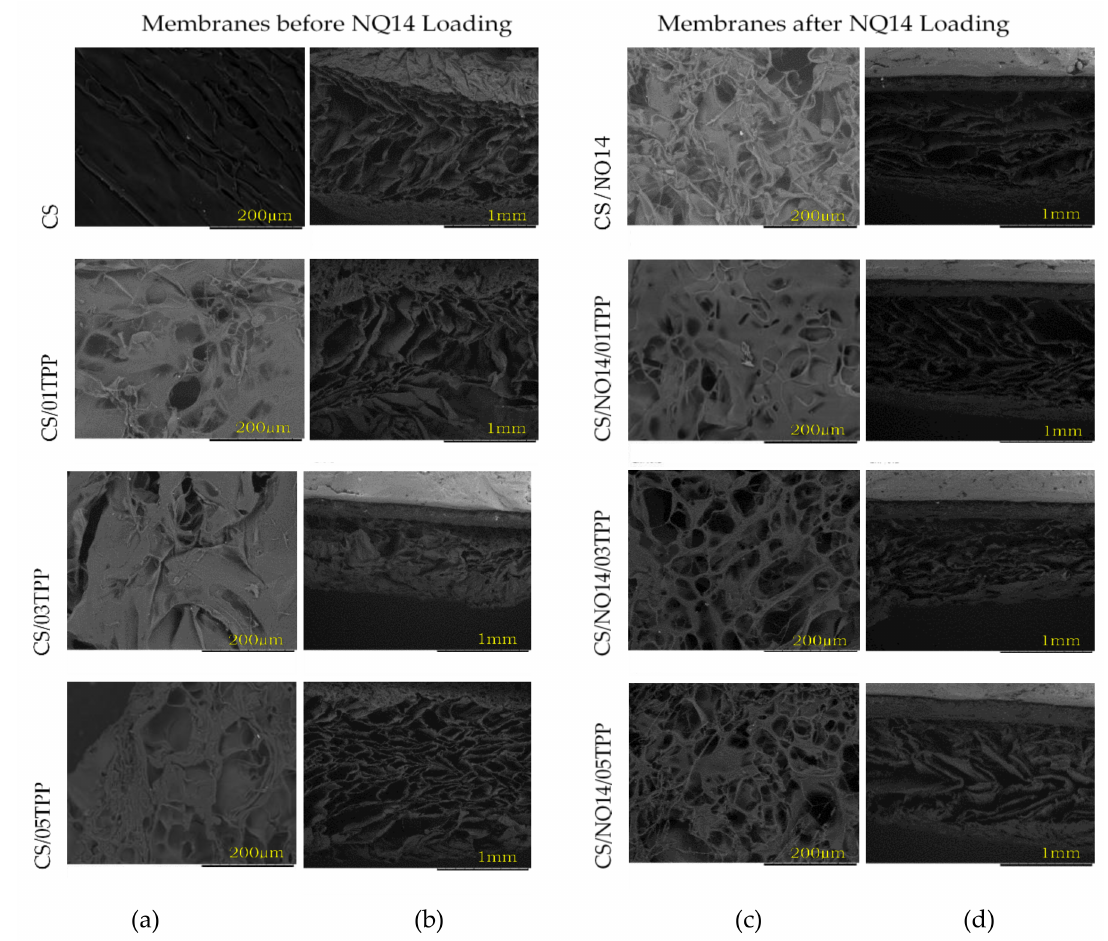
Figure 6. Scanning electron microscope (SEM) photomicrographs of non-crosslinked and ionically crosslinked chitosan membranes before and after NQ14 drug loading, prepared by freezing and lyophilization process: ( a , c ) microstructure from the top surface, and ( b , d ) from the cross section